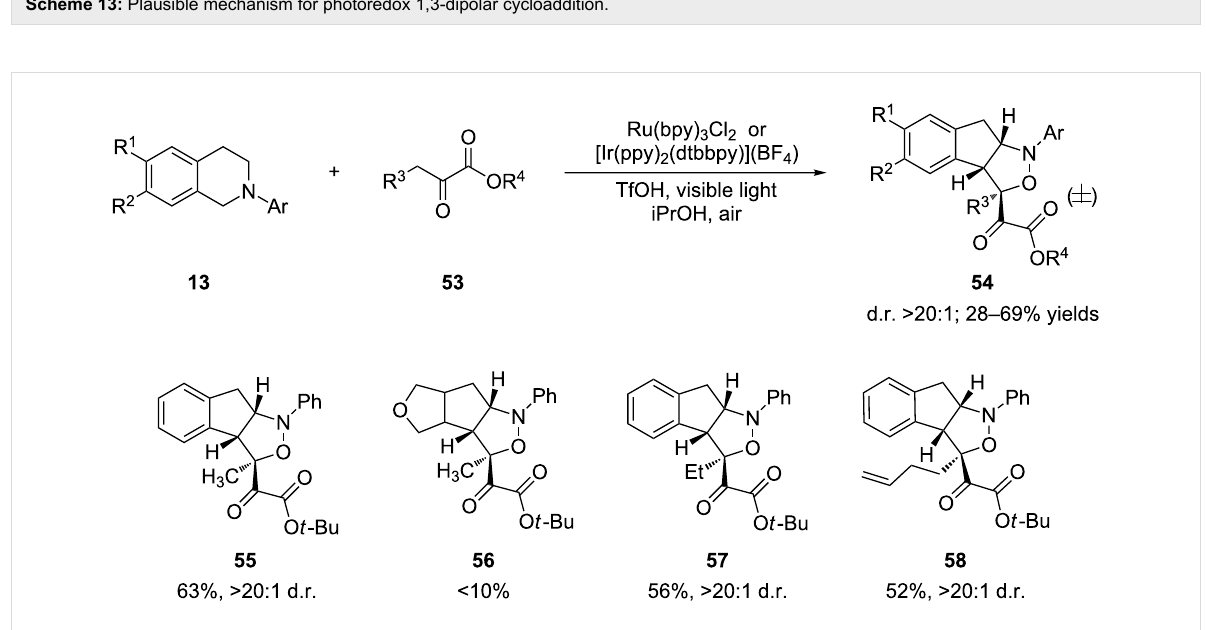
Scheme 14: Photoredox-catalyzed cascade reaction for the synthesis of fused